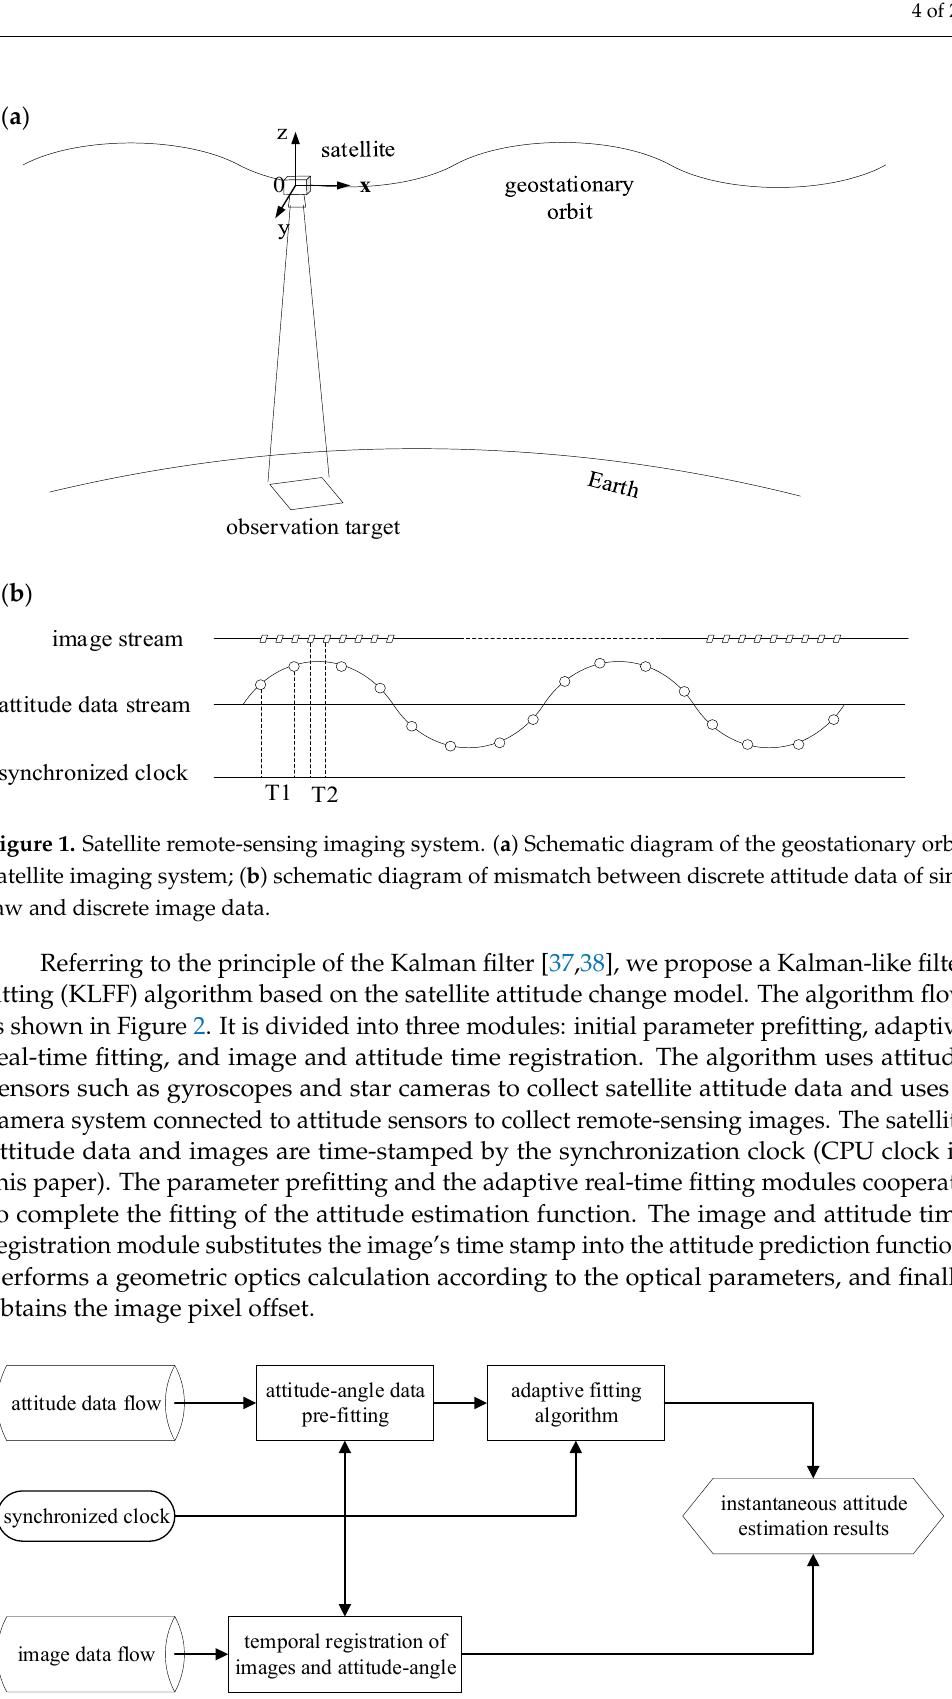
Figure 2. Flowchart of the lightweight adaptive algorithm for instantaneous image pixel offset so- lutions.